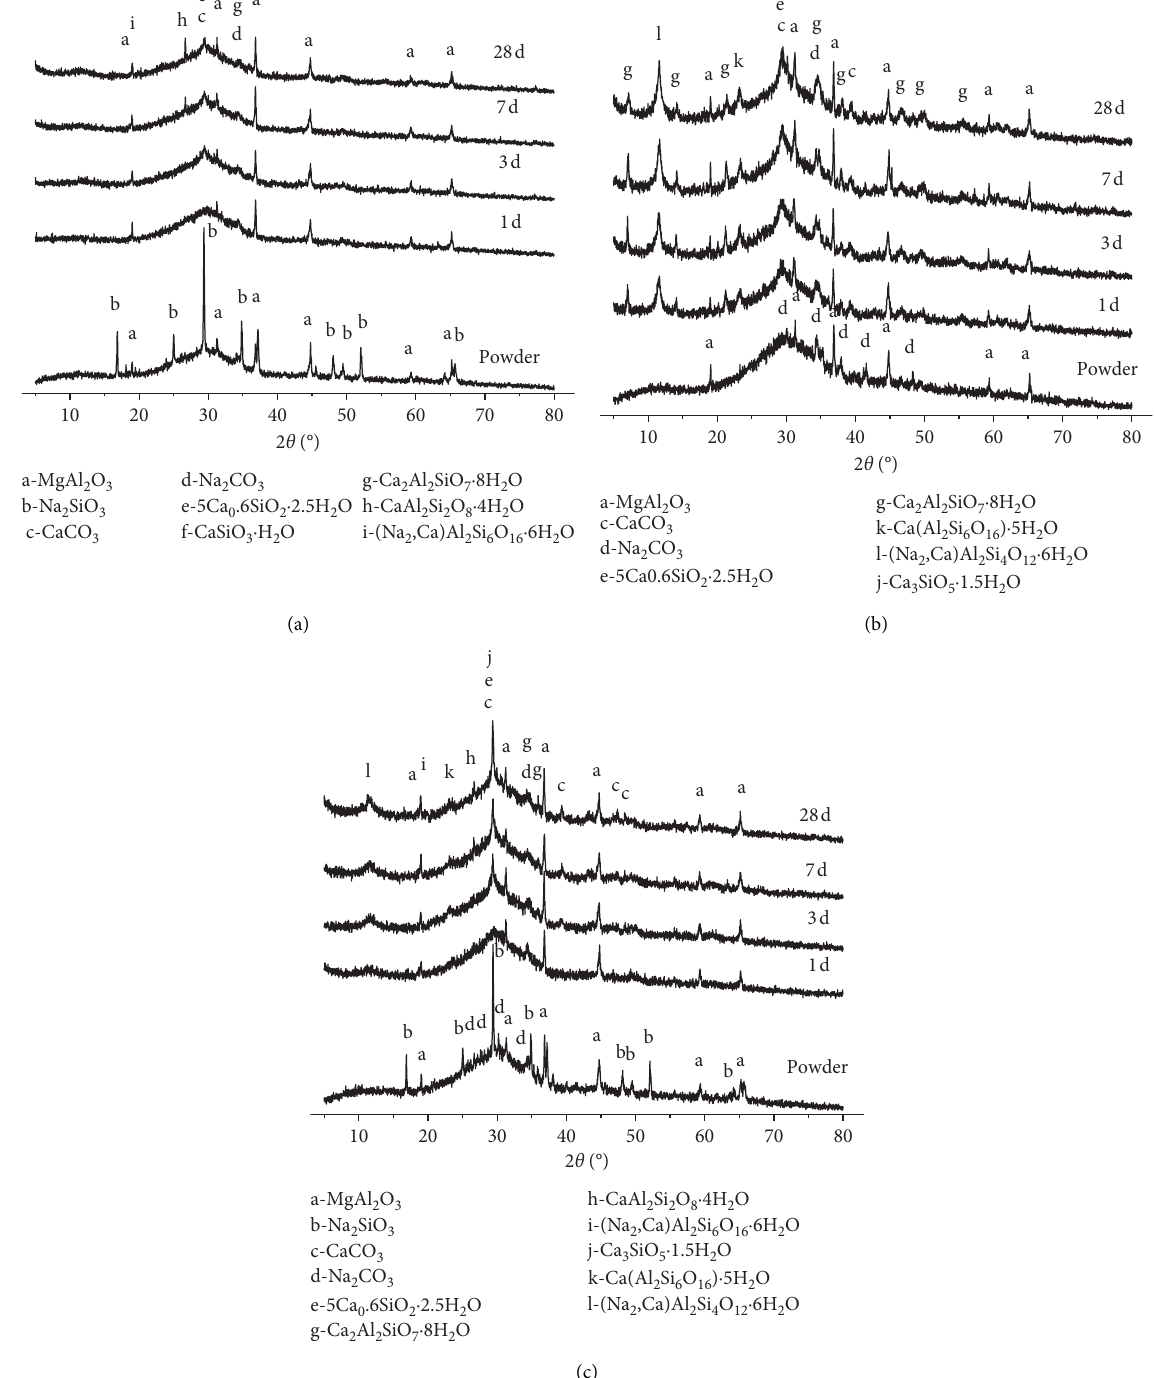
2 O equivalent was 0.107mol.